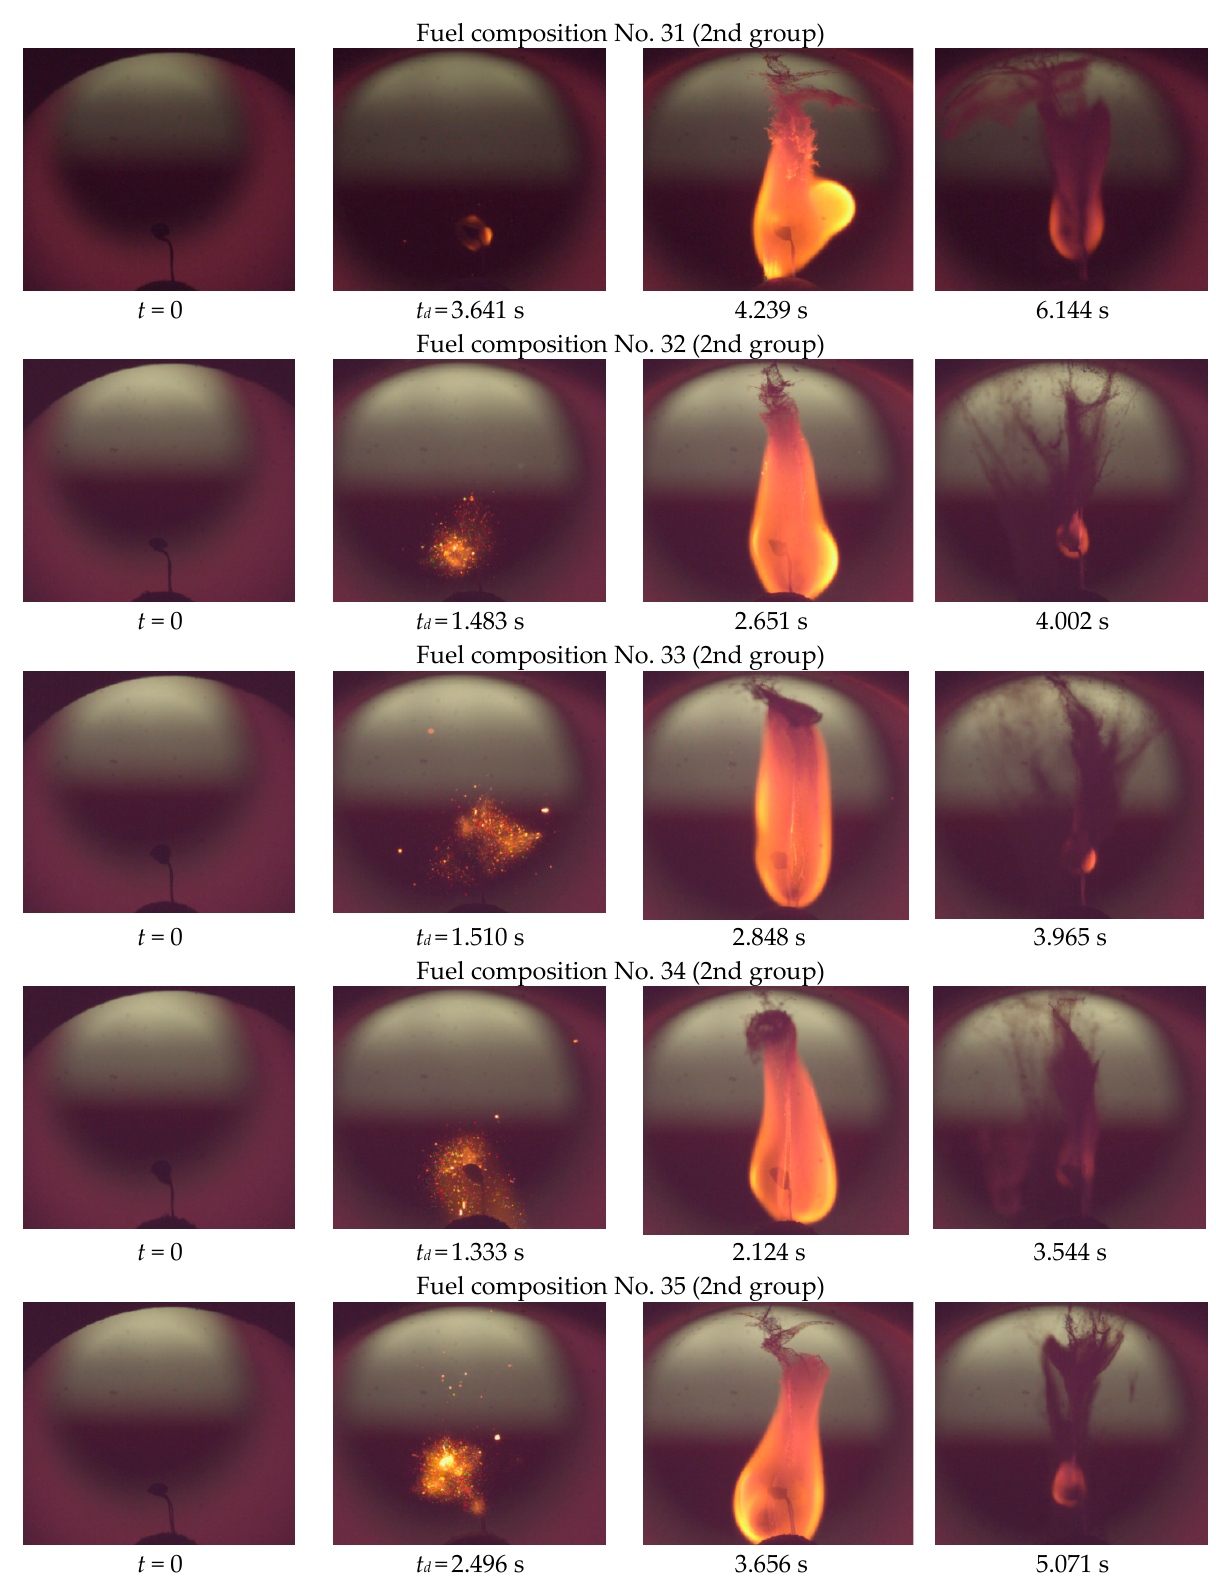
Figure 7. Typical video frames of ignition and combustion of composite fuel droplets at T 0 = 20 °C, T g = 900 °C.